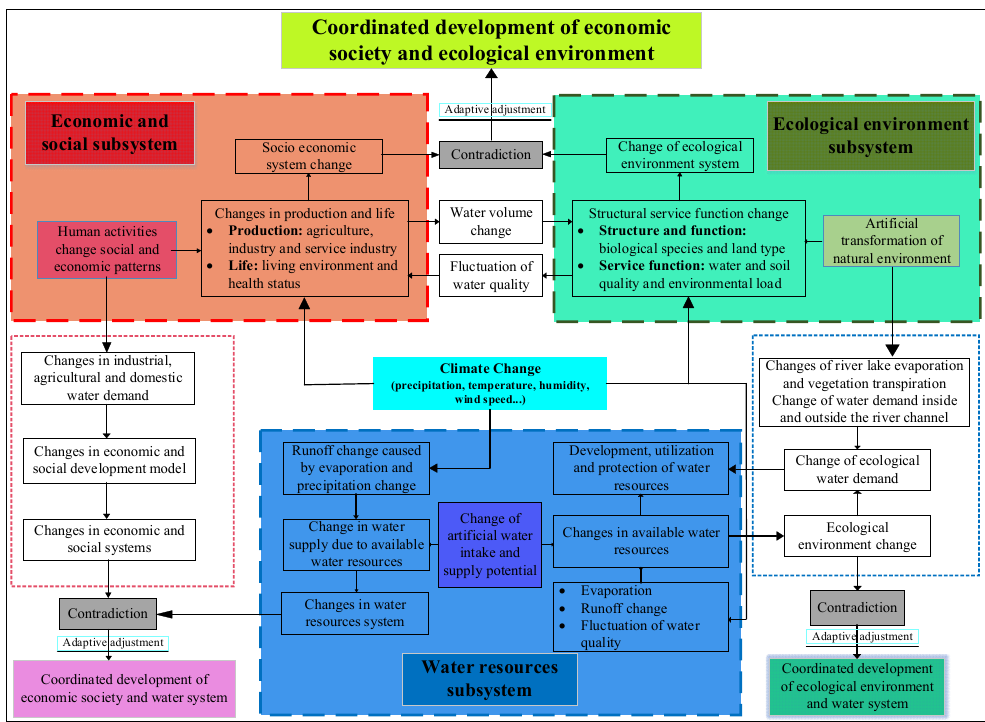
Figure 2. Interaction mechanism of water resources, economic and social systems, and ecological environment affected by climate change and human activities.